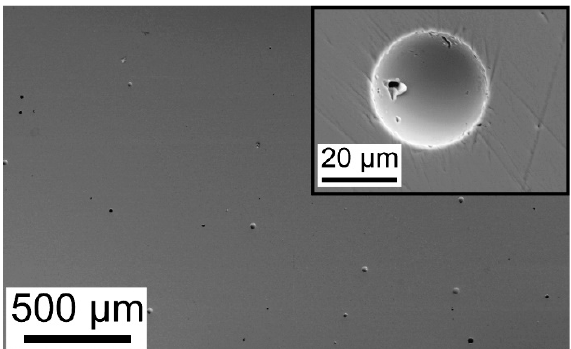
Figure 1. Secondary electron micrograph of the cross-section of the LPBF bulk metallic glass (BMG). Multiple pores can be observed.